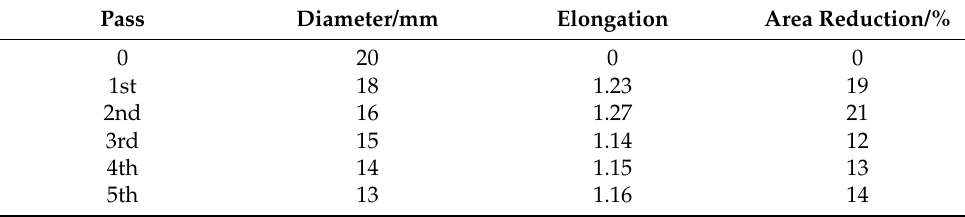
Table 2. Composite material drawing process